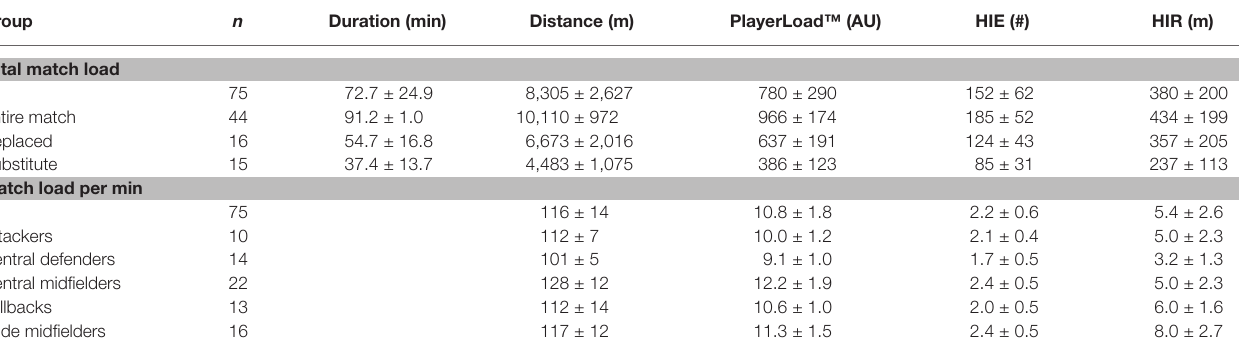
TABLE 2 | Summary of total match load and match load per minute for selected external load variables, for all players and for different groups of players (mean ± SD). Group n Duration